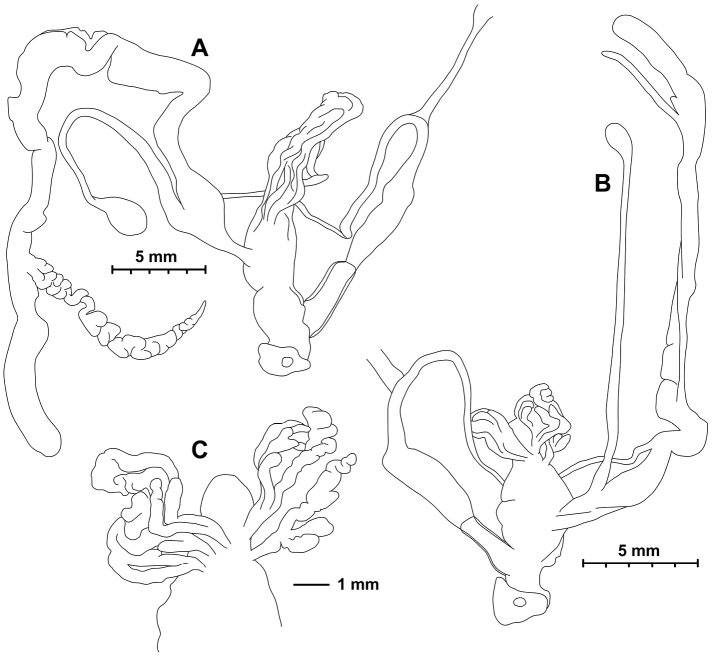
Genital anatomy of TrichocathaicavestitaA Dextral specimen (HNHM 103470) B, C Sinistral specimen (HNHM 103471).